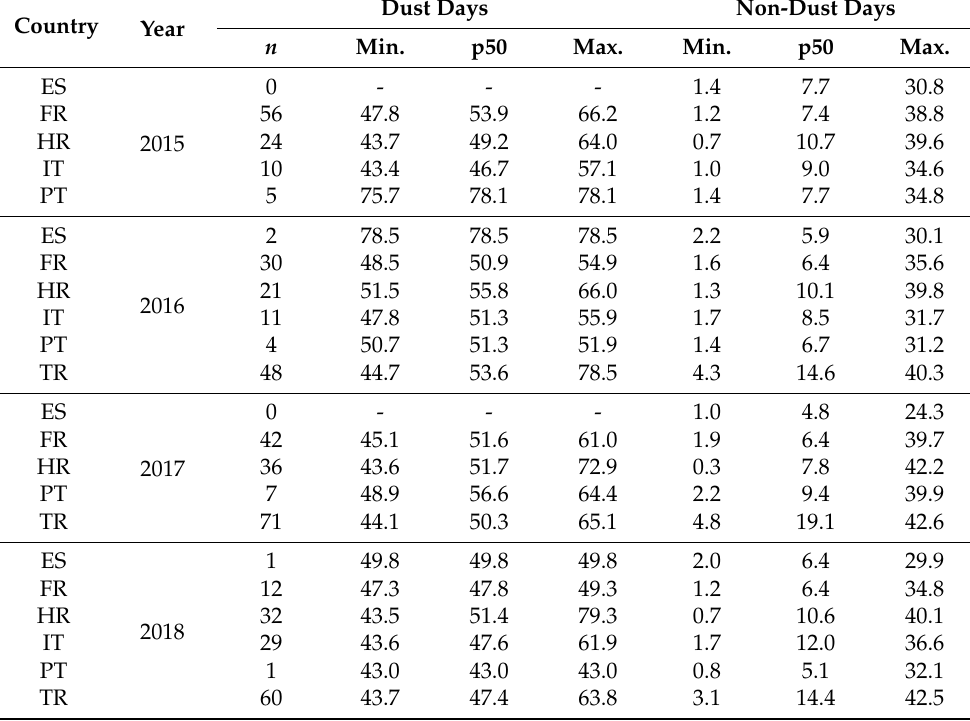
Table 3. Average concentration by country for PM 2.5 time series as in Table 1. n , number of